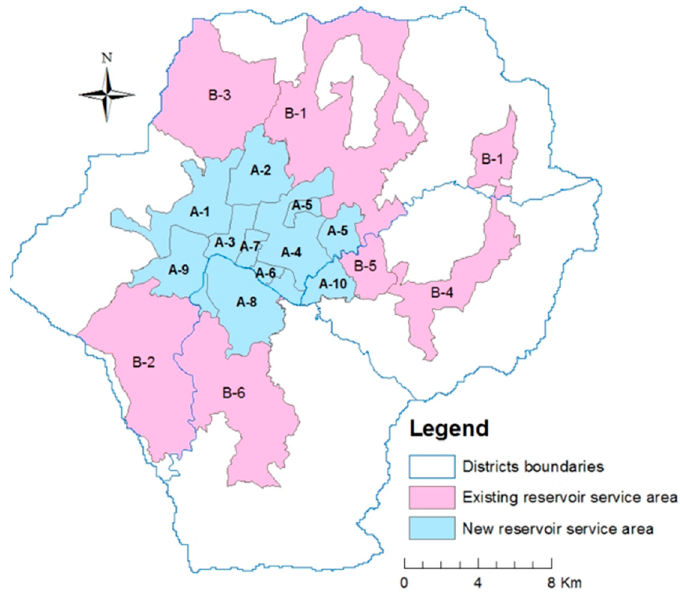
Figure 1. Study area showing KUKL’s planned water supply service area after MWSP.